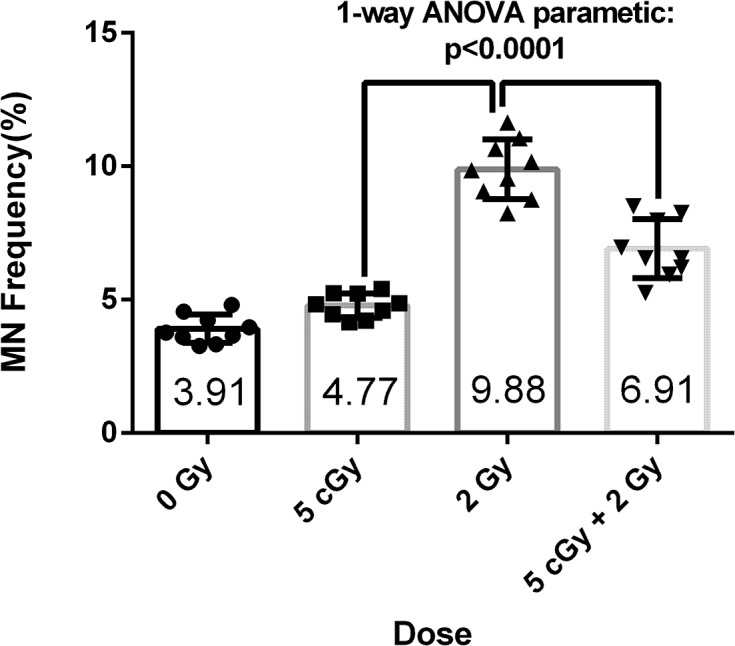
The RAR effect revealed by the micronucleus assay.The 0 Gy group was a sham control, without any radiation treatment. The 5 cGy and 2 Gy groups were irradiated with 5 cGy and 2 Gy doses, respectively. The (5 cGy + 2 Gy) group was irradiated with a priming dose of 5 cGy, followed by a challenging dose of 2 Gy, with a 12 h interval between application of the two doses.